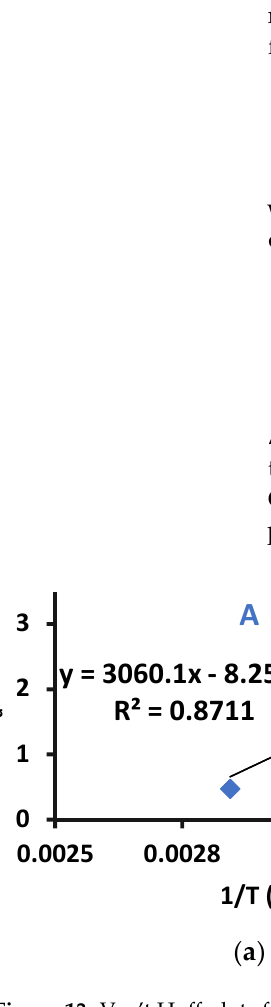
Figure 13. Van’t Hoff plots for the adsorption of difenoconazole by ( A ) Cell-D (C I : 10 ppm, pH: 8, time: 20 min), ( B ) Cell-X (C I : 8 ppm, pH: 6, time: 60 min), (dosage: 10 mg, volume: 10 mL).